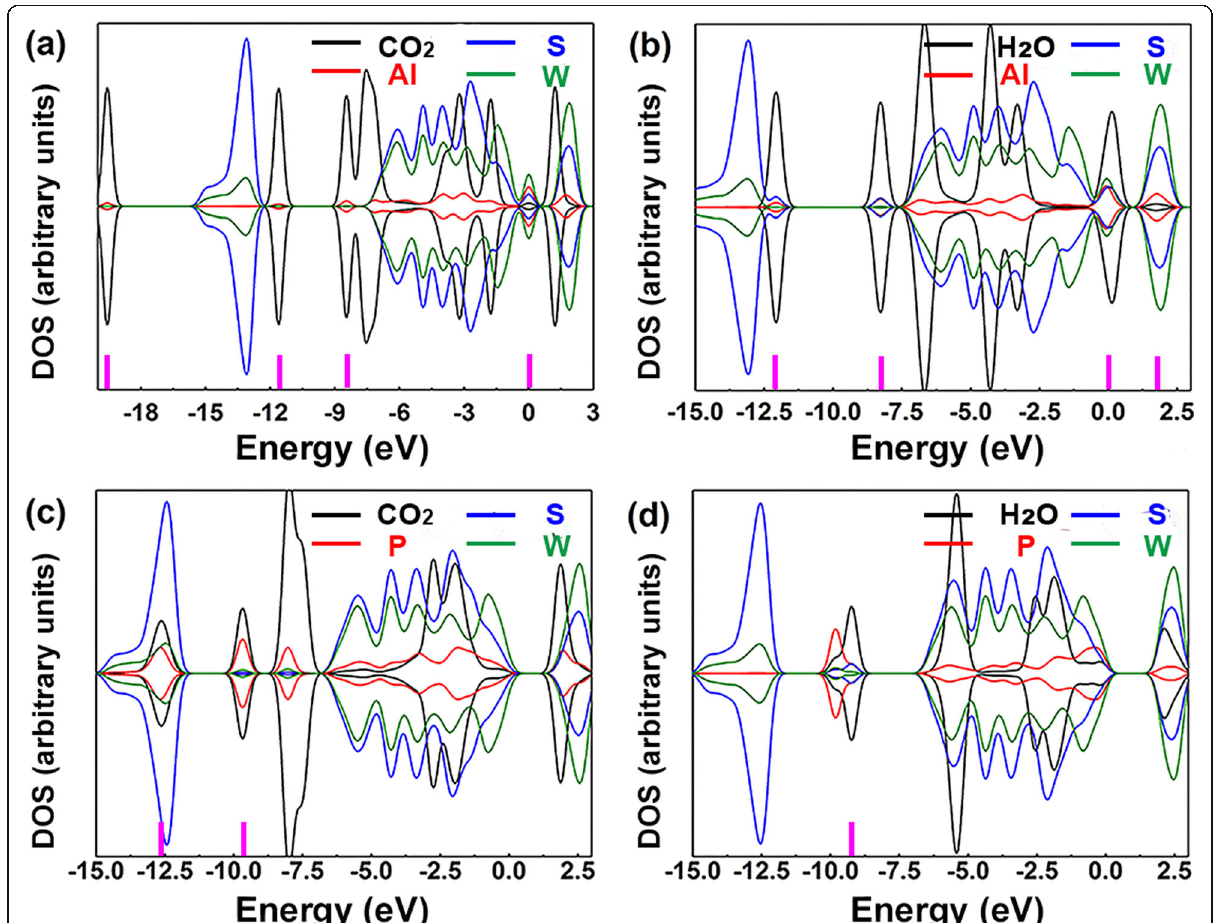
Fig. 6 DOS of a CO 2 , Al, S, and W atoms; b H 2 O, Al, S, and W atoms; c CO 2 , P, S, and W atoms; and d H 2 O, P, S, and W